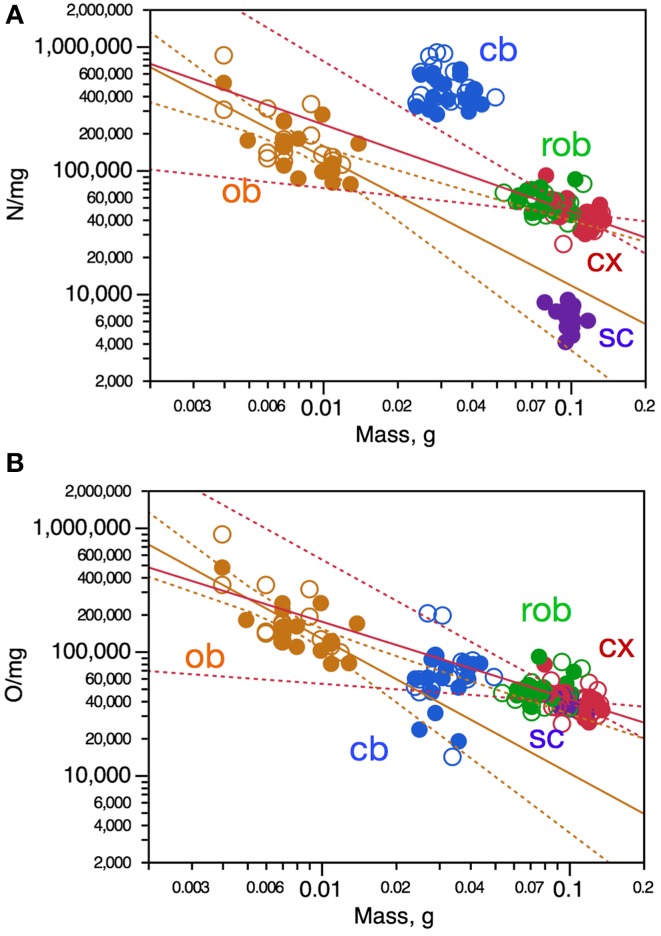
Variation in neuronal density (A) and other cell density (B) is only poorly correlated with variation in CNS structure mass across mouse individuals. Each data point represents one CNS structure in one individual. Values for brain structures refer to right (filled symbols) and left sides (open symbols) separately. Cx, cerebral cortex (gray and white matter combined); cb, cerebellum; ob, olfactory bulb; rob, rest of brain; sc, spinal cord. (A) Spearman correlation coefficients for each structure: ob, ρ = −0.5684, p = 0.0009; cx, p = 0.0802; rob, p = 0.1859; cb, p = 0.3777; sc, p = 0.3163. Only the power functions with significant exponents are shown: ob, exponent, −1.038 ± 0.229, r2 = 0.415, p < 0.0001; cx, exponent, −0.702 ± 0.240, r2 = 0.222, p = 0.0065; cb, p = 0.2308; rob, p = 0.3911; sc, p = 0.3163. (B) Spearman correlation coefficients for each structure: ob, ρ = −0.6446, p < 0.0001; cx, p = 0.0986; cb, p = 0.0950; rob, p = 0.6386; sc, p = 0.2126. Only the power functions with significant exponents are shown: ob, exponent, −1.087 ± 0.209, r2 = 0.482, p < 0.0001; cx, exponent, −0.626 ± 0.235, r2 = 0.191, p = 0.0123; cb, p = 0.6135; rob, p = 0.2248; sc, exponent, −0.705 ± 0.279, p = 0.0216.